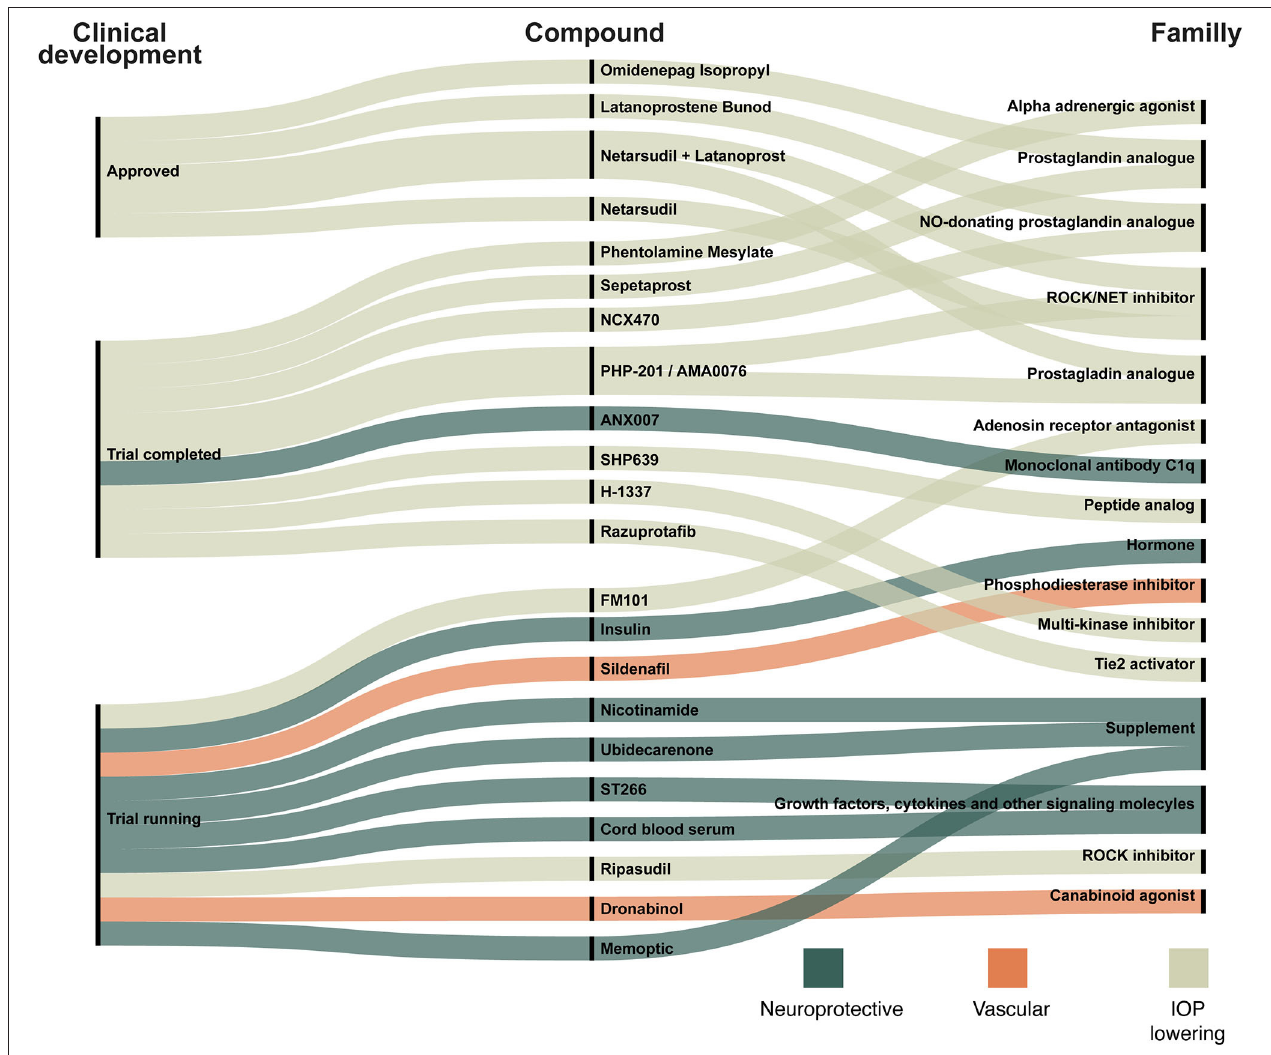
FIGURE 4 | New compounds in ongoing trials, trials completed within 2 years and compounds resulting in recently approved glaucoma treatment drugs. The compounds are linked to the target family listed on the right site. The three colors indicate whether a compound is categorized as neuroprotective (dark